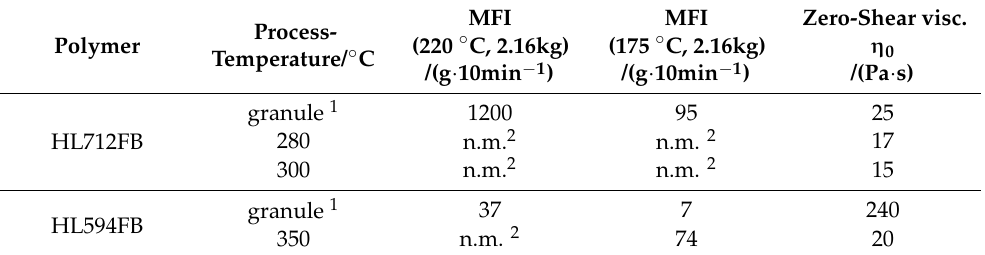
Table A1. Examination of the degradation of polypropylene under different process